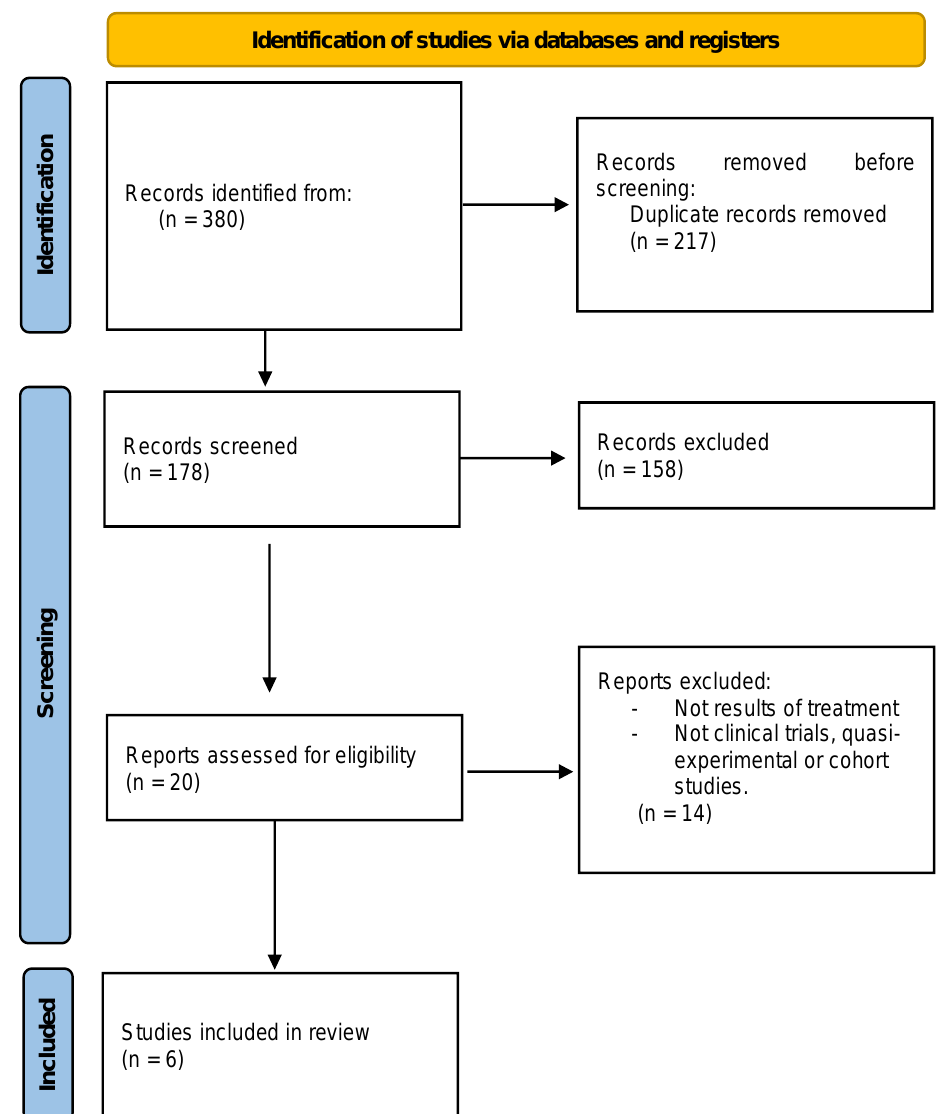
Figure 1. PRISMA flowchart of articles selection process